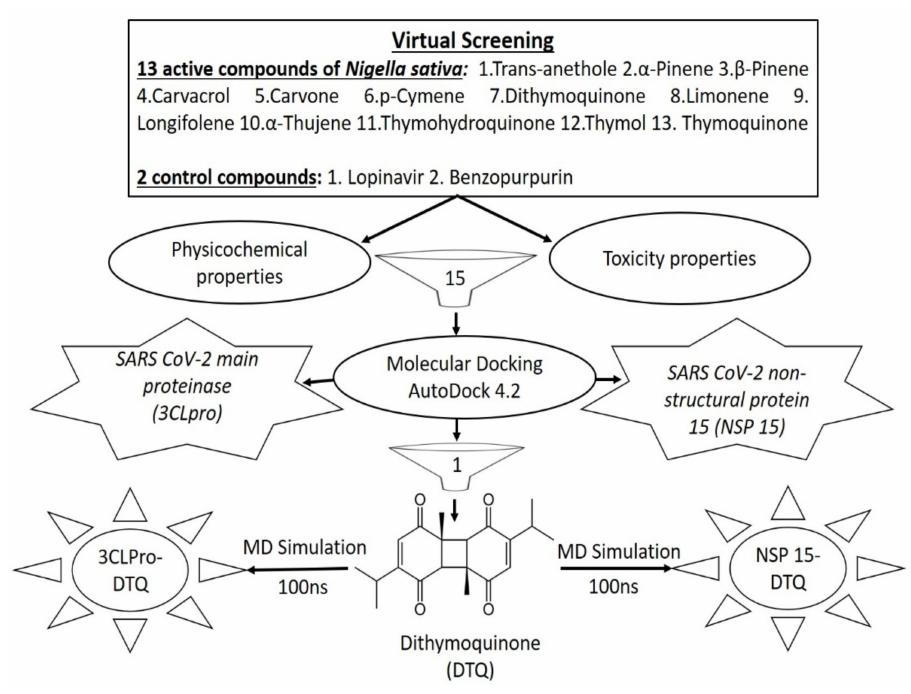
Figure 1. Virtual screening of Nigella sativa compounds to select the best dual-targeting compound against the SARS-CoV-2